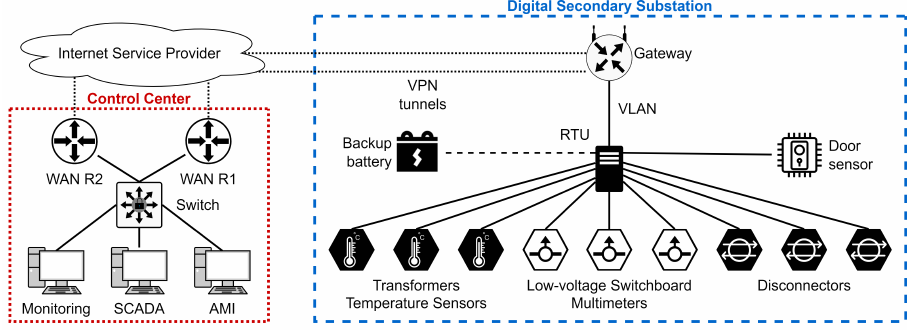
Figure 3. Digital secondary substation and its connection with the control